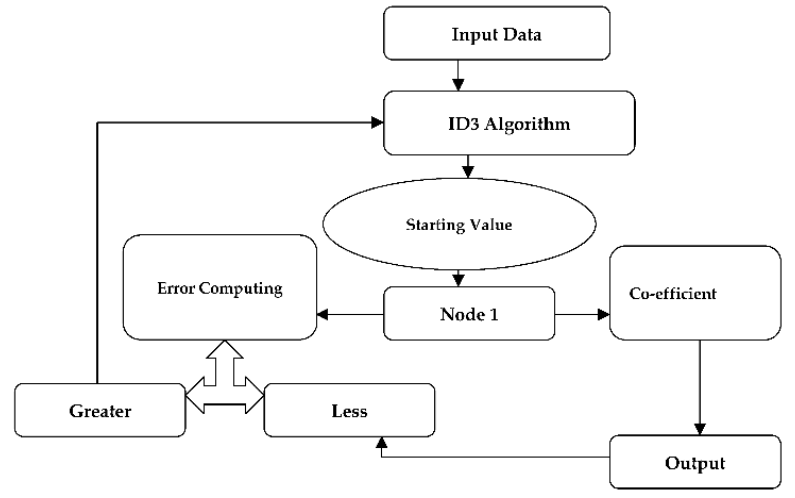
Figure 4. Flow sheet diagram of Tree Boost technique.